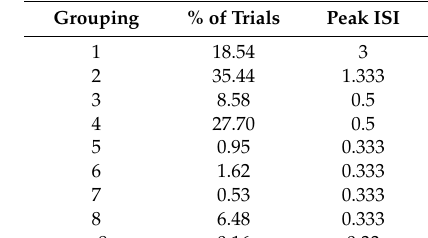
Table A3. Summary of reported groupings in the metronome task; grouping of 1 corresponds to no integration of beats.